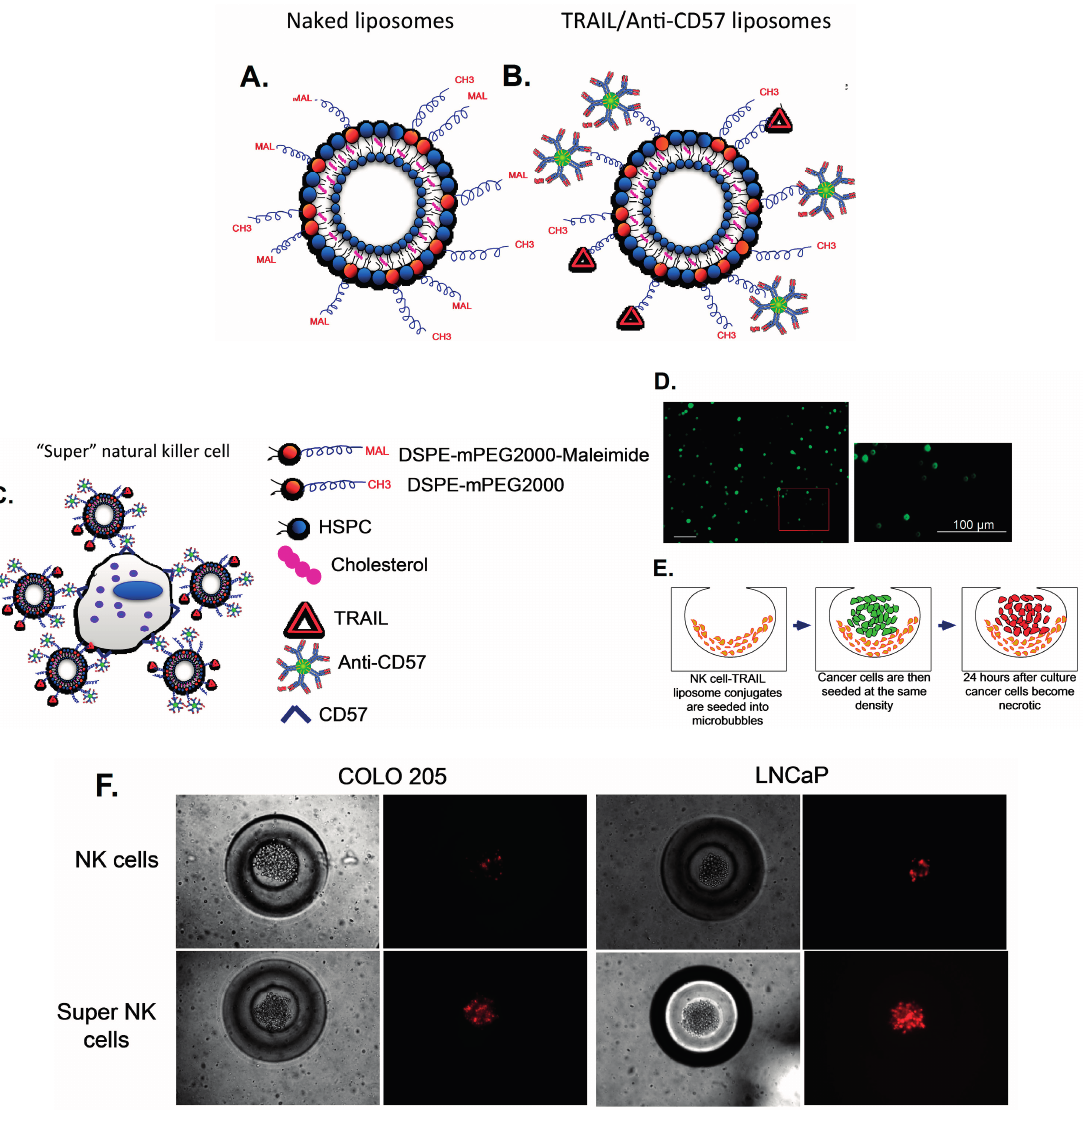
Figure 5. Delivering therapeutic TRAIL-liposomes to the TDLN by targeting NK cells: ( A ) Schematic of liposomes with maleimide functional group; ( B ) thiolated anti-CD57 and TRAIL covalently bound to liposomes; ( C ) “Super” NK cells are liposome functionalized NK cells via antibody binding to CD57 on the surface of NK cells; ( D ) confocal micrographs of NK cells conjugated to fluorescent liposomes with inset showing an even distribution of liposomes on the NK cell surface (Scale bar = 100 μ m) ( E ) “Super” NK cells and LN-seeking cancer cells cultured in 3D microbubbles; and ( F ) Fluorescent micrographs of COLO205 and LNCaP cells cultured with endogenous NK and “super” NK cells for 24 h in microbubbles incubated with propidium iodide (red) to stain for necrotic cancer cells. Reproduced by permission of the Royal Society of Chemistry from Ref. [187]. DSPE: 1,2-distearoyl- sn - glycero-3-phosphoethanolamine; HSPC: hydrogenated soy phosphatidylcholine; PEG: polyethylene